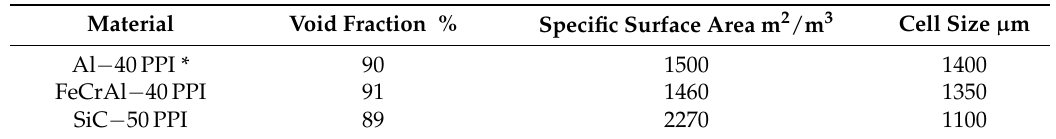
Table 1. Characteristics of the different open cell foams, determined by image analysis of X-ray tomography. * PPI is for “pores per inch”.